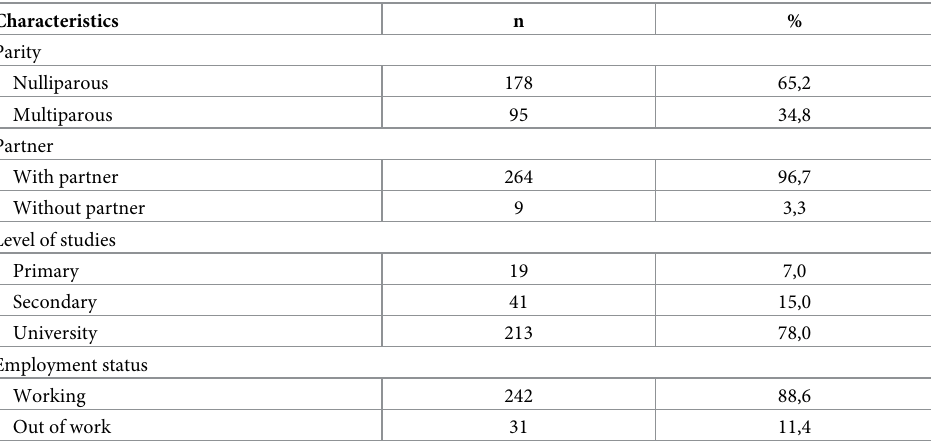
Table 3. Participant characteristics.